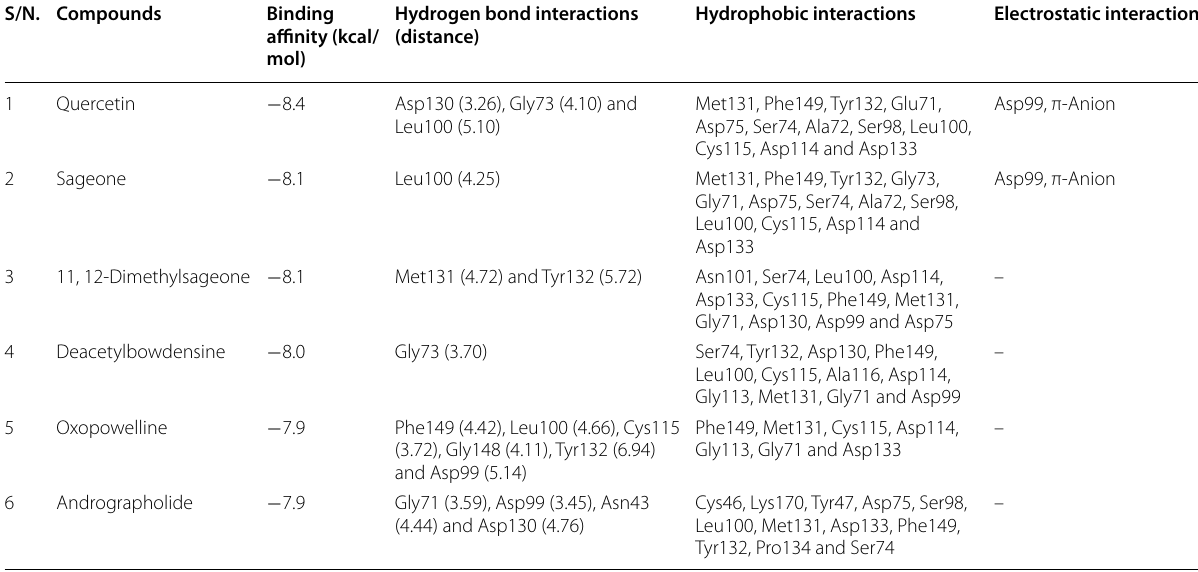
Table 3 Binding affinity and molecular interactions of the six hit compounds when docked against nsp16 S/N.